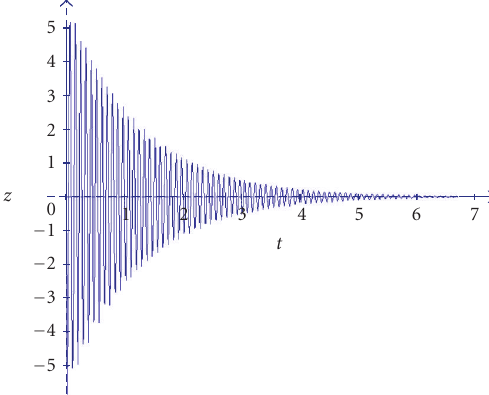
Figure 6.7 . Stable solution of (5.2) in the point F (544 . 5,34), a 0 =